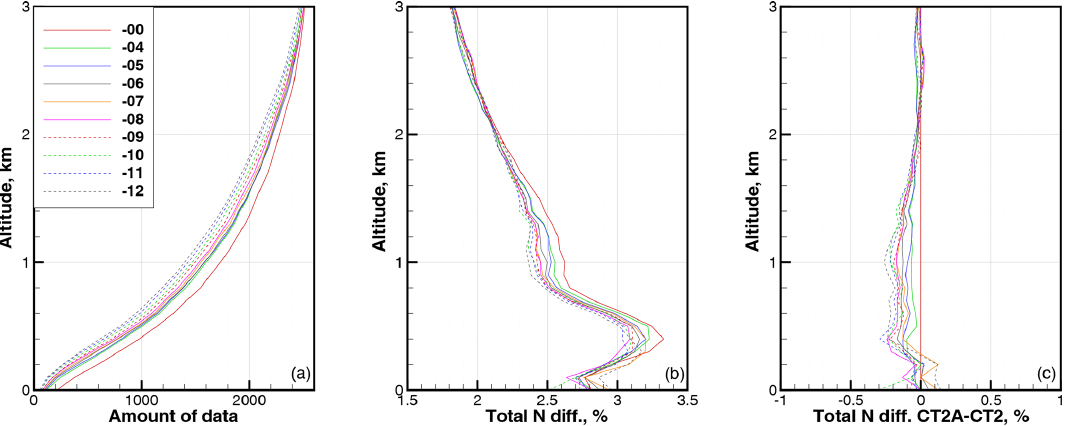
Figure 12. Statistics for latitude band 0–10 ◦ evaluated for subsets common for β = 0 and each other value of β . (a) Amount of data. (b) RMS relative difference in refractivity COSMIC–ECMWF (cid:49)N CE . (c) RMS relative difference in refractivity CT2A–CT2. All are functions of the parameter β .